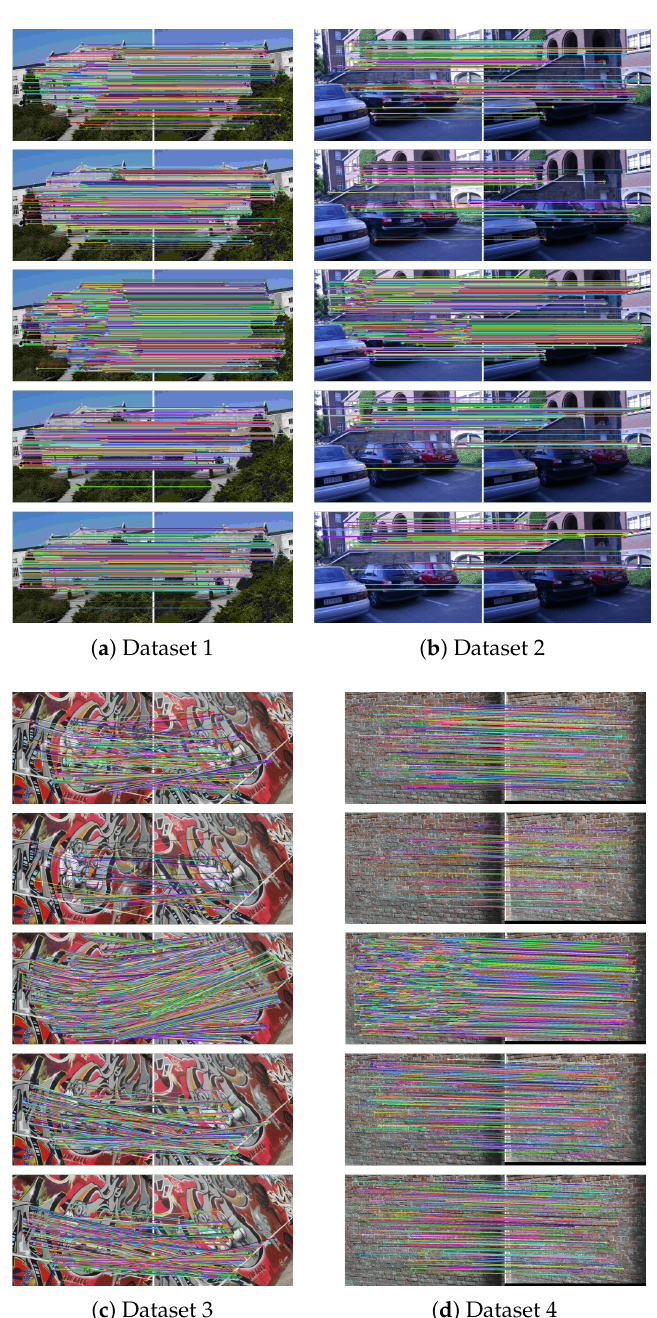
Figure 6. Matching images by using four benchmark imagery datasets demonstrating different variations with five algorithms (from top to bottom: EABRISK, SC-EABRISK, SC-EABRISK with ATBB, BEBLID, LATCH). Table 1. Number of keypoints detected and feature pairs (FPs) of each benchmark image pair in the four color spaces. Color